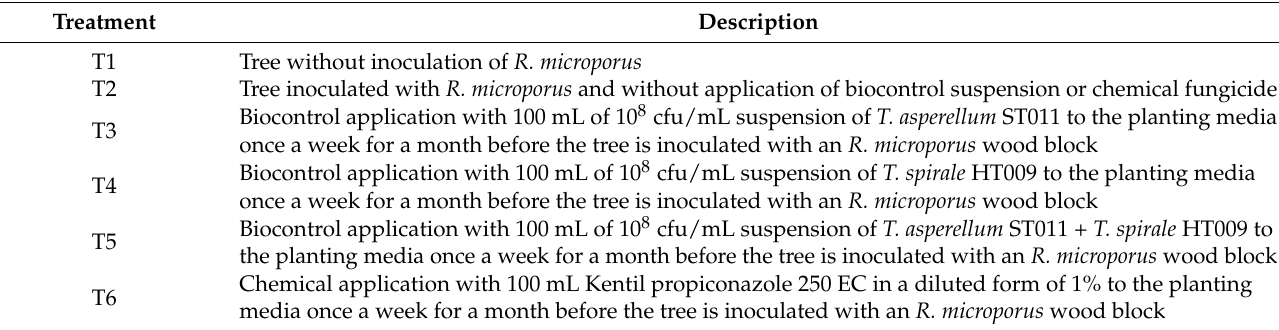
Table 1. Type of treatments on rubber seedlings using Trichoderma suspensions and chemical fungicide for white root rot disease assessment in the